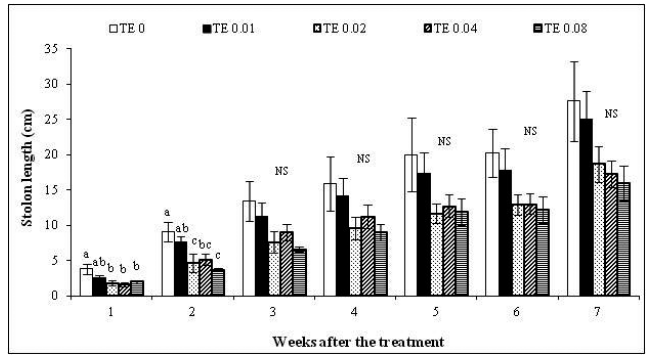
Fig. 1 - Stolon length in Patriot bermudagrass treated with different rates of TE (kg a.i. ha -1 ). Within the same week, different let- ters show significantly different values for P≤0.05 (LSD test). Vertical bars show se of the means (n=5); ns= not significant.